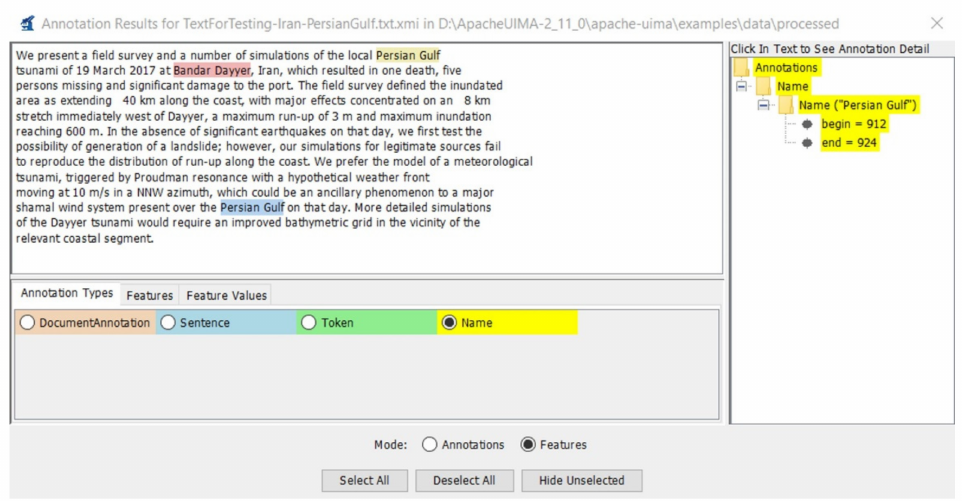
Figure 6. Annotation of the unstructured text about meteotsunami in the Apache UIMA frame-